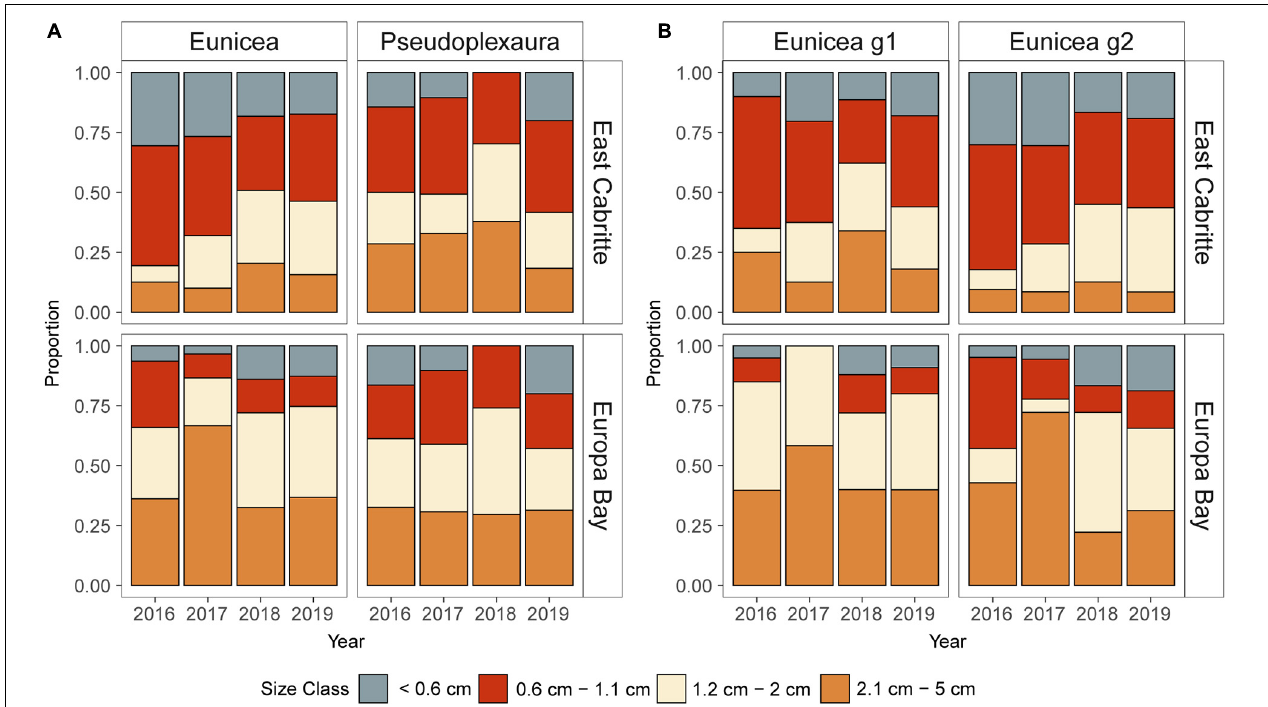
FIGURE 6 | Stacked bar graphs depicting the size frequency distributions of colonial recruits at East Cabritte and Europa Bay from 2016 to 2019. (A) Eunicea spp. and Pseudoplexaura spp. recruits. (B) Eunicea calyx sizes Eunicea g1 (With prominent calyces) and Eunicea g2 (without prominent calyces). Independently of genus or calyx size, small recruits ( ≤ 1.1 cm tall) were proportionately more common at East Cabritte, while larger recruits ( > 1.2 cm tall) were more common at Europa Bay ( p < 0.001).